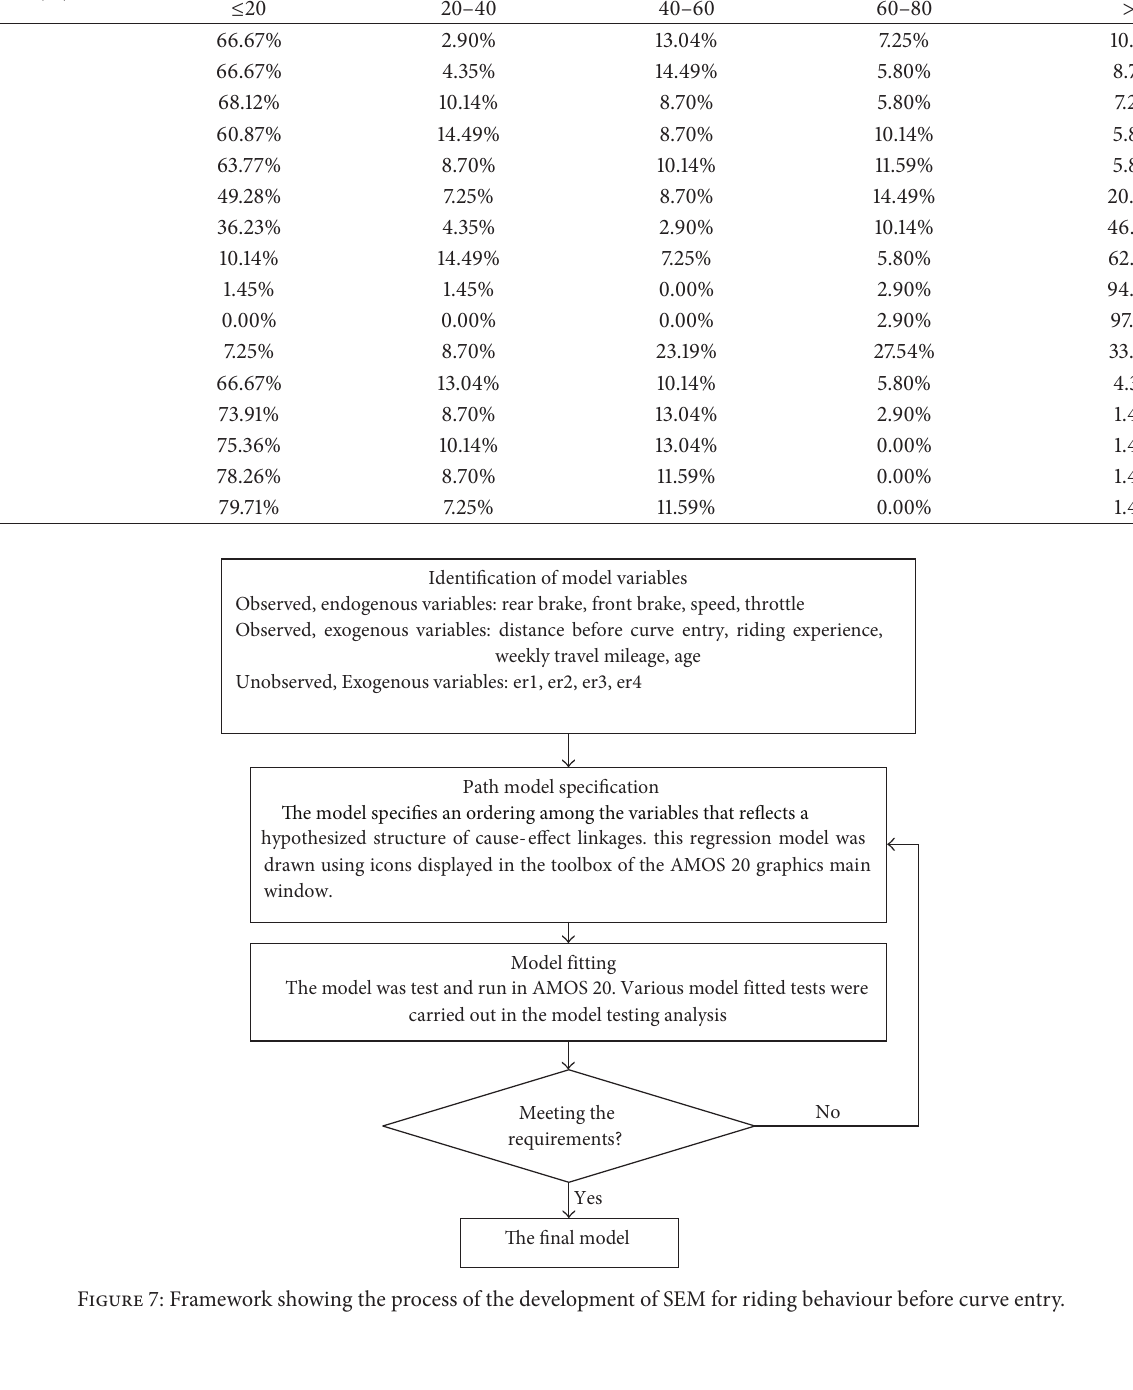
freedom (35 − 29 = 6) , and the chi-squared goodness-of-fit was computed. The result indicates that the model did not fit the data well by chi-square test, 𝜒2(𝑁 = 414, df = 6) = 190.211 , 𝑃 < 0.05 . Although the hypothesized model did not fit the observed variance-covariance matrix well by the chi- square test, the baseline comparisons fit indices of Normal Fit Index (NFI), Relative Fit Index (RFI), Incremental Fit Index